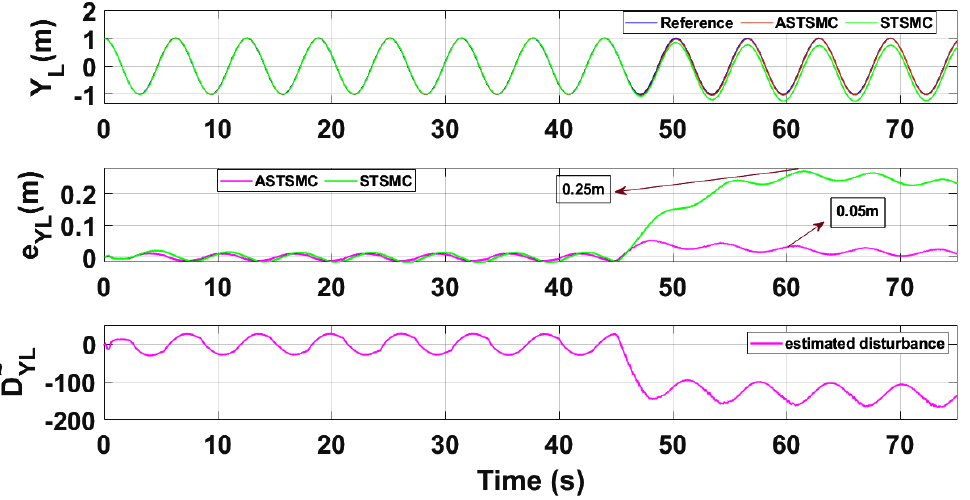
Figure 10. Y leader tracking comparison under wind